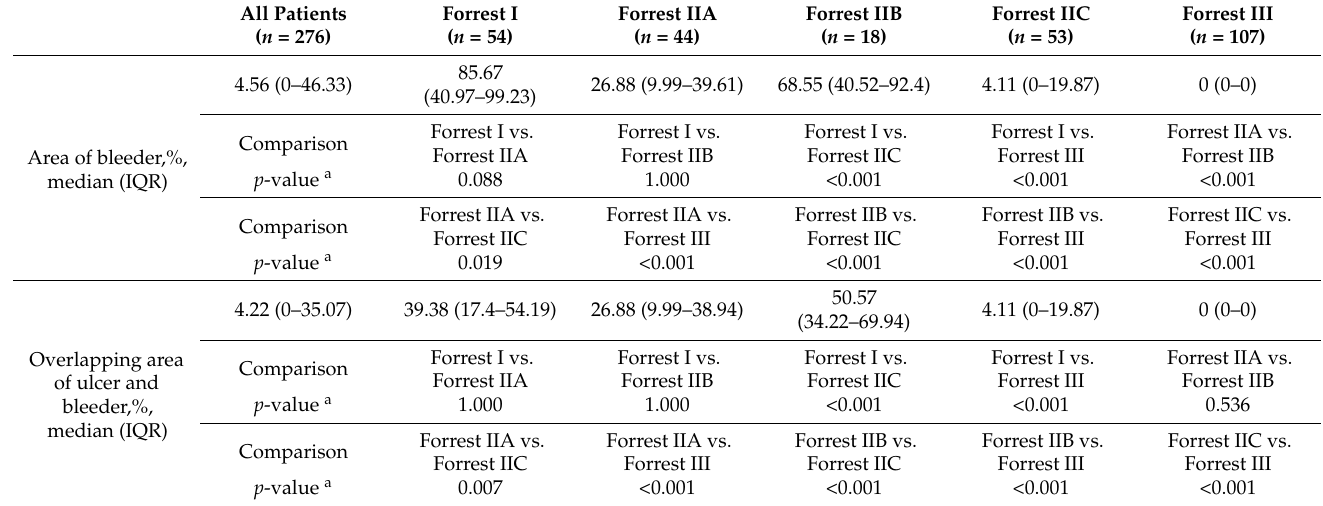
Table 3. Comparison of bleeder patterns among different Forrest classes of the endoscopy images.